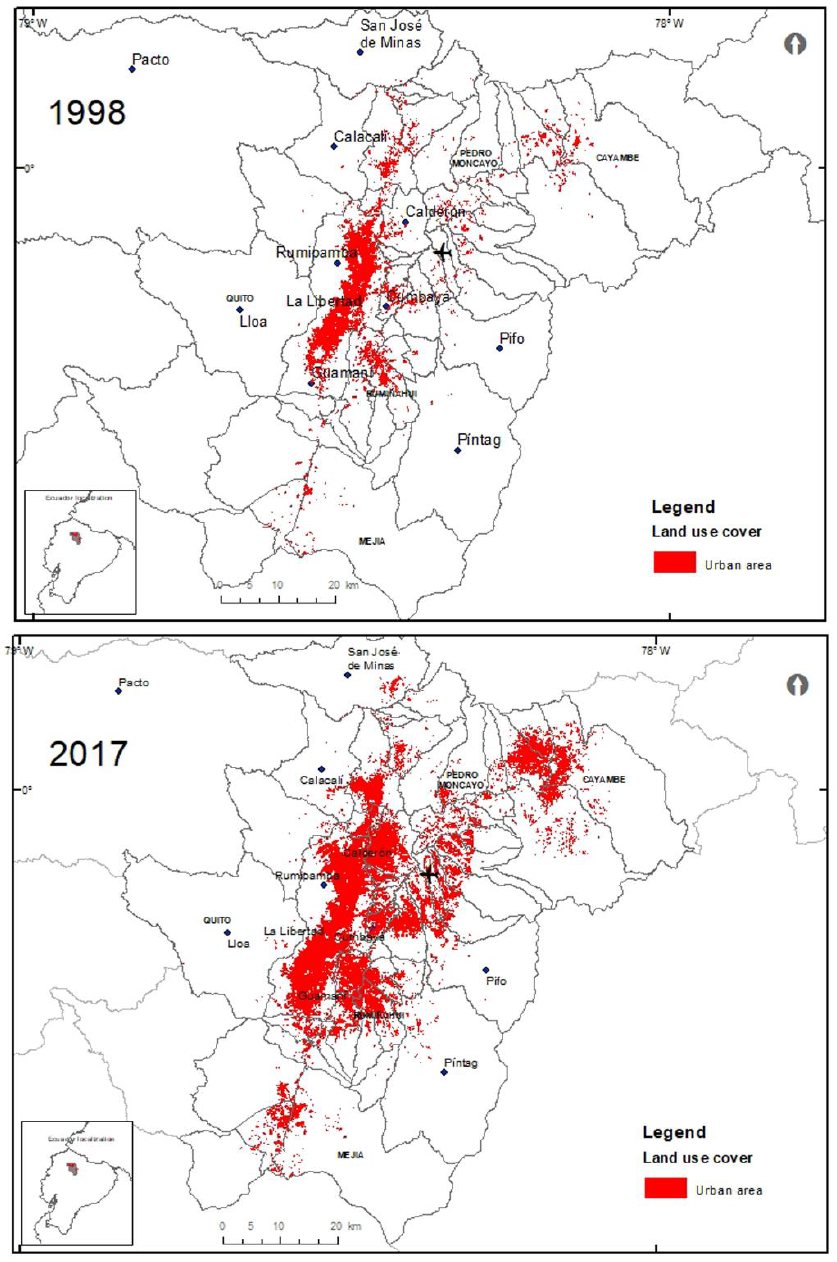
Figure 4. Urban land use change of Quito and surrounding 1998 –